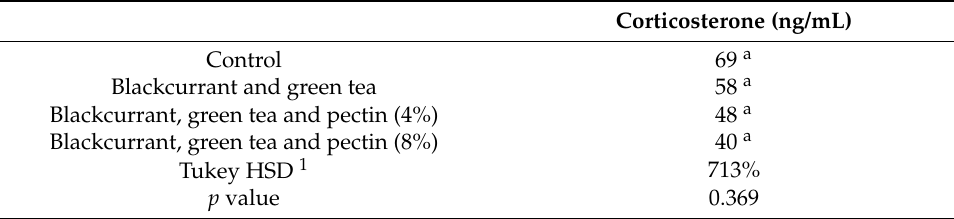
Table 5. Rat plasma